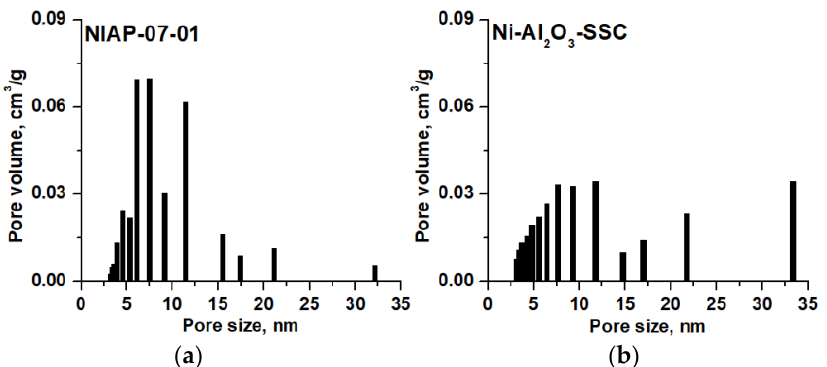
Figure 11. Pore size distribution for ( a ) NIAP-07-01 and ( b ) Ni-Al 2 O 3 -SSC catalysts. Table 3. Texture characteristics of Ni-Al 2 O 3 -SSC and NIAP-07-01 catalysts. Catalyst